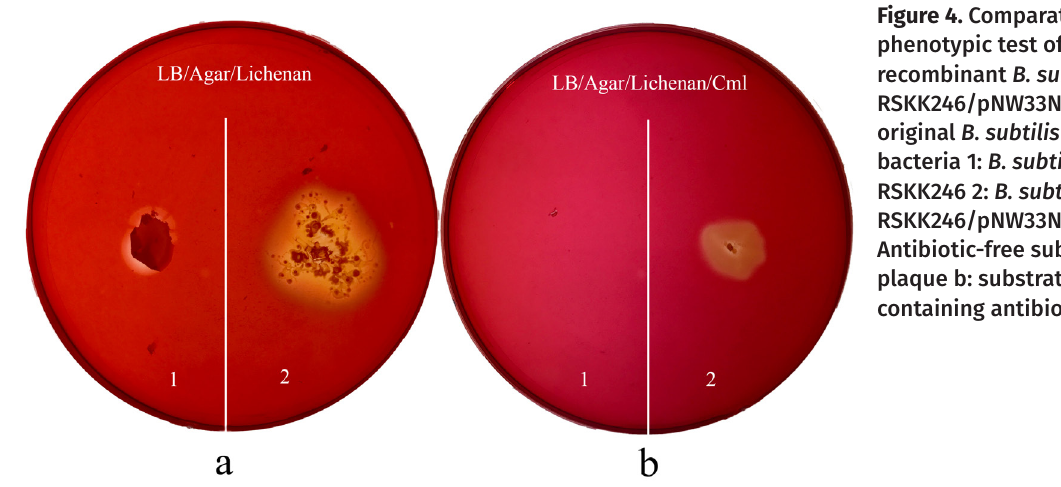
Figure 4. Comparative phenotypic test of recombinant B.